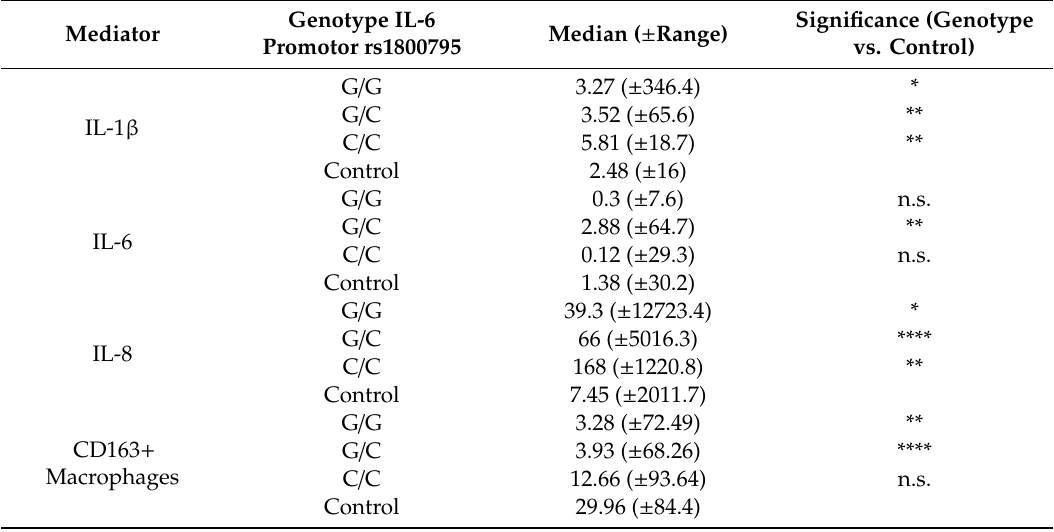
Table 5. Cytokine plasma concentrations and percentages of CD163 positive M2 macrophages related to the IL-6 promotor SNP rs1800795 genotypes. Mann–Whitney-U non-parametric tests were